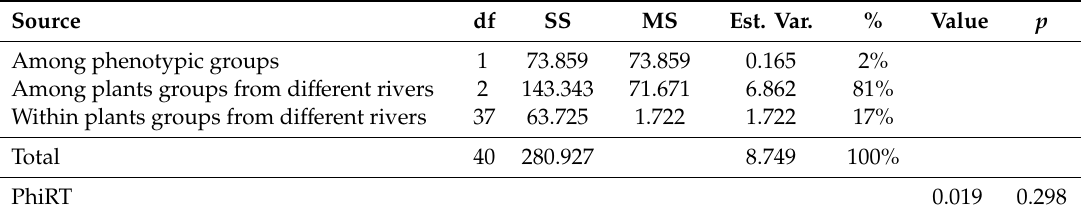
Table 2. Analysis of molecular variance (AMOVA) for di ff erent groups of Ranunculus section Batrachium . Df—degrees of freedom; SS—sum of squared deviation; MS—mean squared deviation; Est.Var.—estimated variance;